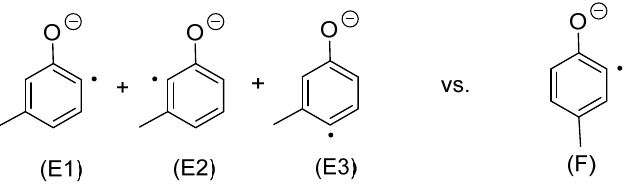
Scheme 10. Steric e ff ect of substituents on the intumescence.